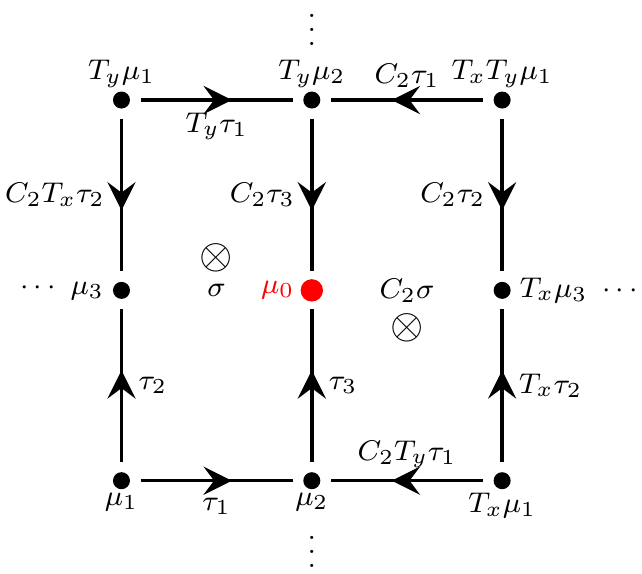
Figure 2: The cell decomposition for 2D wall paper group. The rotation center is marked in red. Here, we use σ to label 2-cells, τ for 1-cell and µ for 0-cell. Cell g α is obtained from α by acting symmetry g . Their orientation are marked by